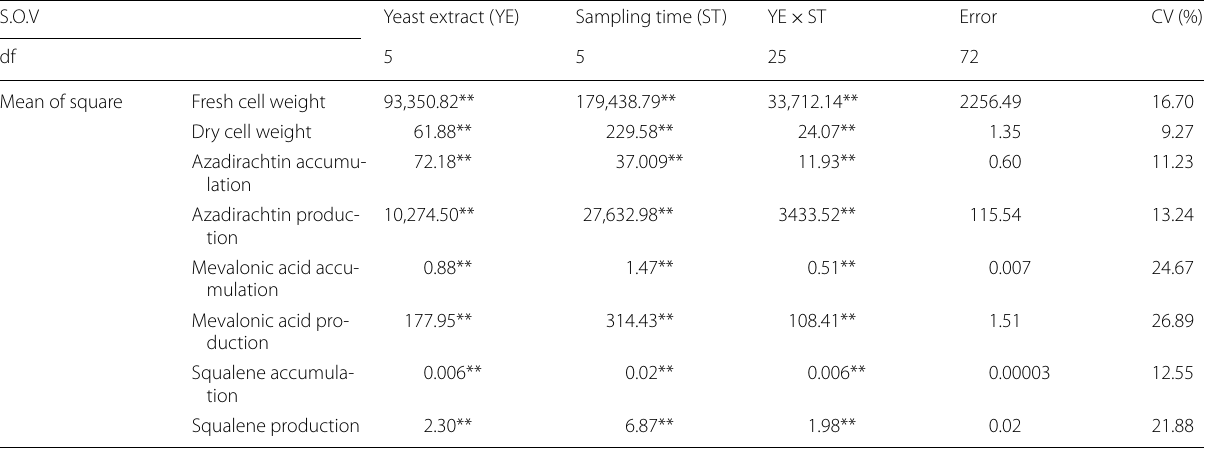
* and **significant at 5% and 1% probability level, respectively